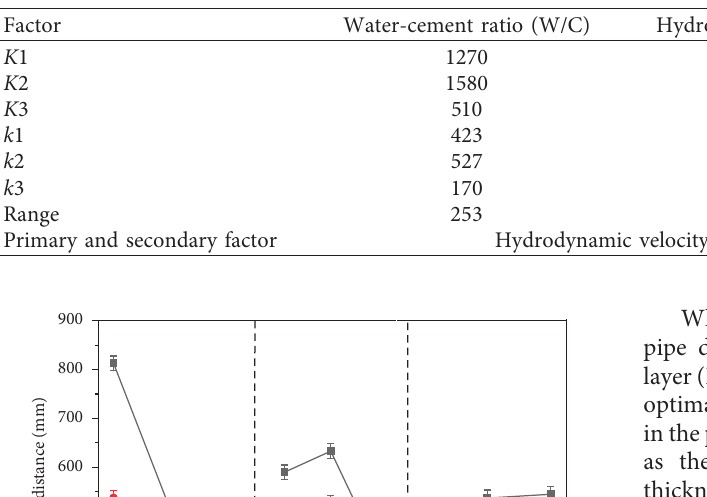
Table 7: Reverse diffusion distances in the 50 mm diameter pipe.